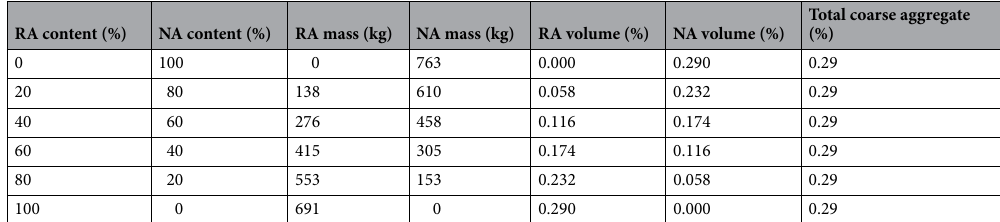
Table 9. RA and NA volumetric content, Chen et al. 35